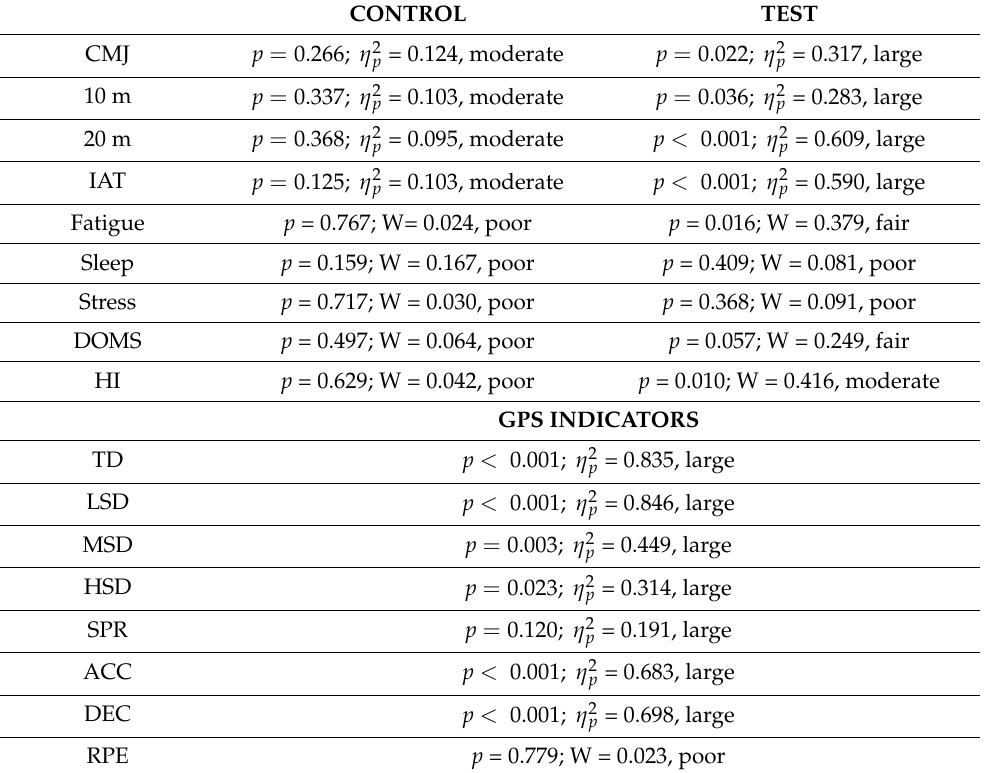
Table 1. Results for the one-way